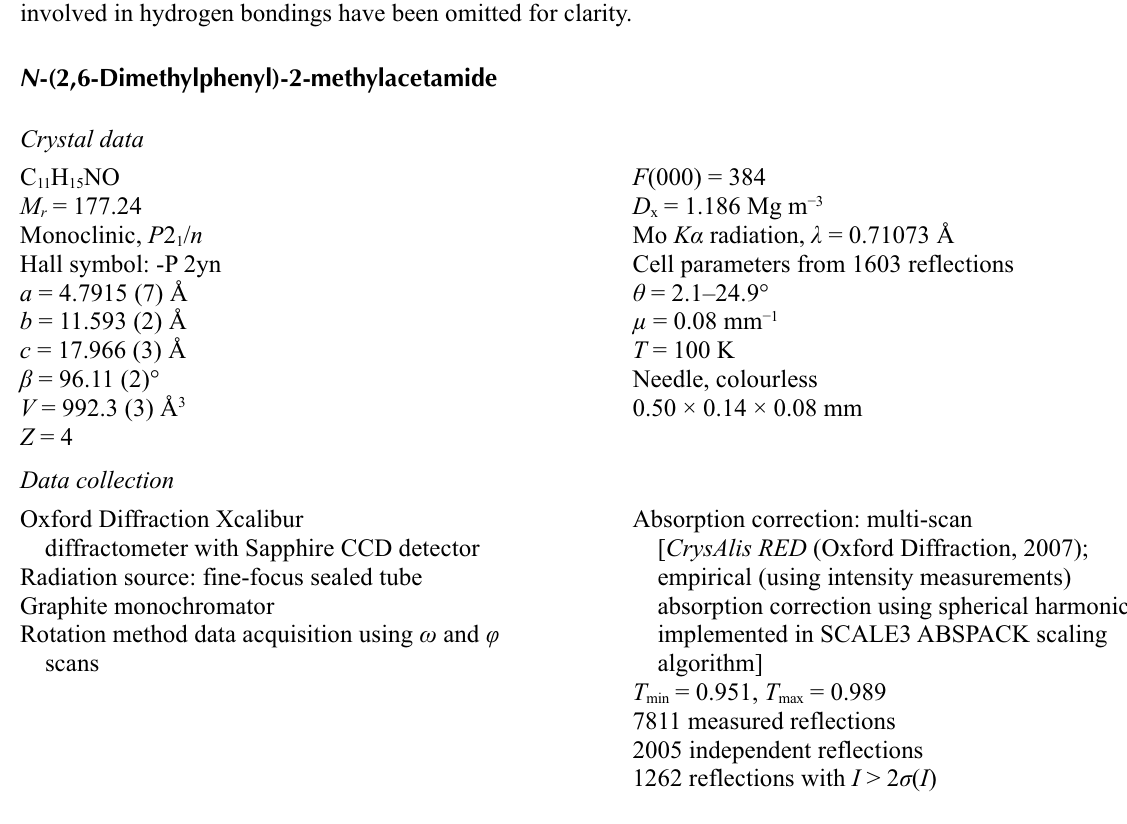
Partial packing view showing the formation of a chain. Hydrogen bonds are represented as dashed lines. H atoms not involved in hydrogen bondings have been omitted for